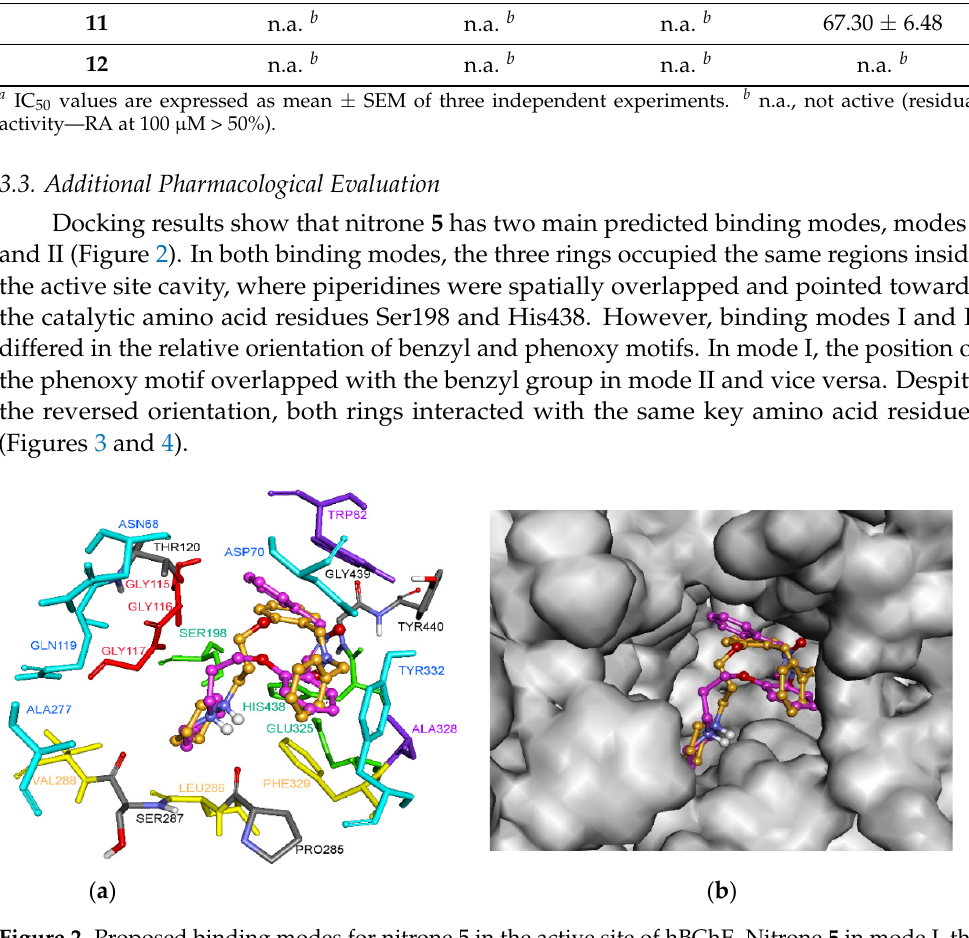
Figure 3. Schematic 2D representation of hBChE binding site amino acids interacting with nitrone 5 . Binding mode I.